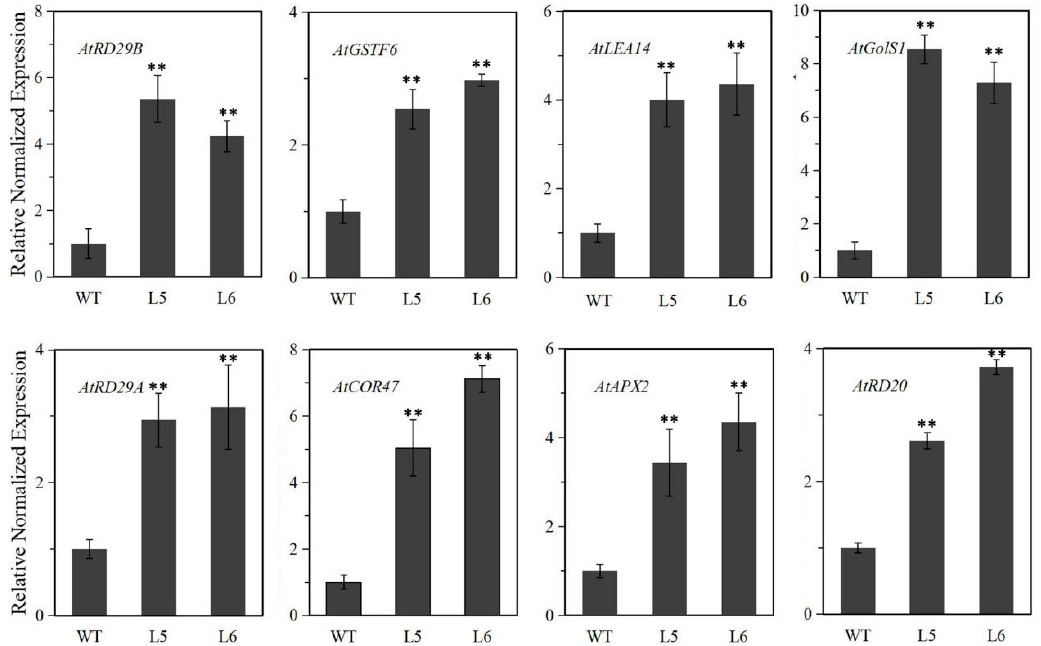
Figure 9. Transcript levels of the stress-related genes under normal condition in WT and LlNAC2 transgenic Arabidopsis plants. Three biological replications were performed. The bars show the SD. Asterisks indicate a significant difference (** p < 0.01) compared with the corresponding controls.